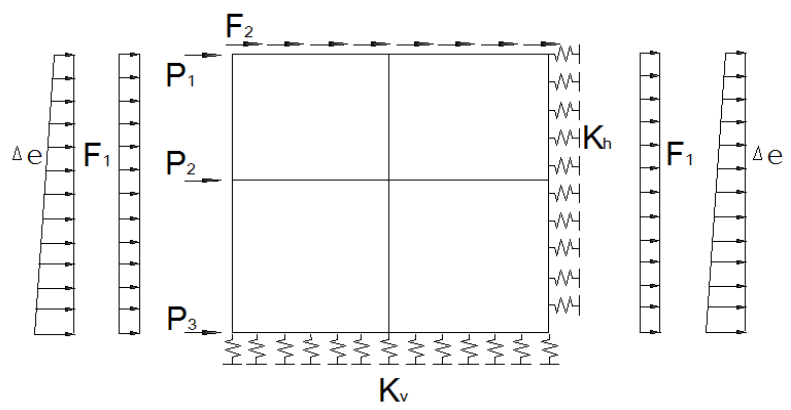
Figure 1. FBM calculation model.